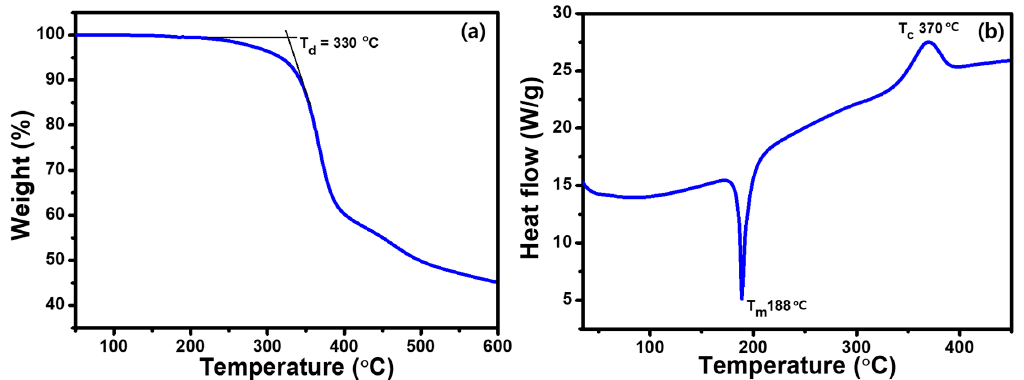
Figure 1. ( a ) Thermogravimetric analysis (TGA) and ( b ) differential scanning calorimetry (DSC) plots of DVB-T-ID SOMs.